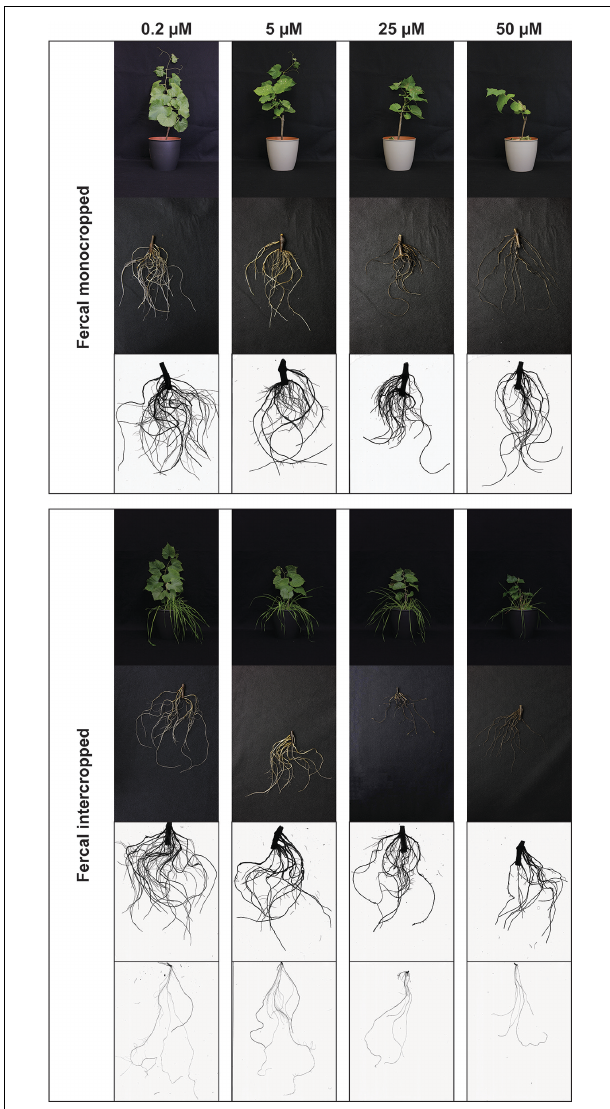
FIGURE 1 | Phenotype of Fercal rootstock plants grown at different Cu concentrations. Representative pictures of Fercal rootstocks (shoots, roots, and a representative WinRhizo Scan of the root apparatus) in both growing conditions (mono- and intercropping) at different concentrations of Cu (0.2–5–25–50 µ M). When presenting intercropping condition, also a representative WinRhizo Scan of oat root apparatus is shown. Pictures have been taken at harvest, i.e., 14 days after Cu treatment.